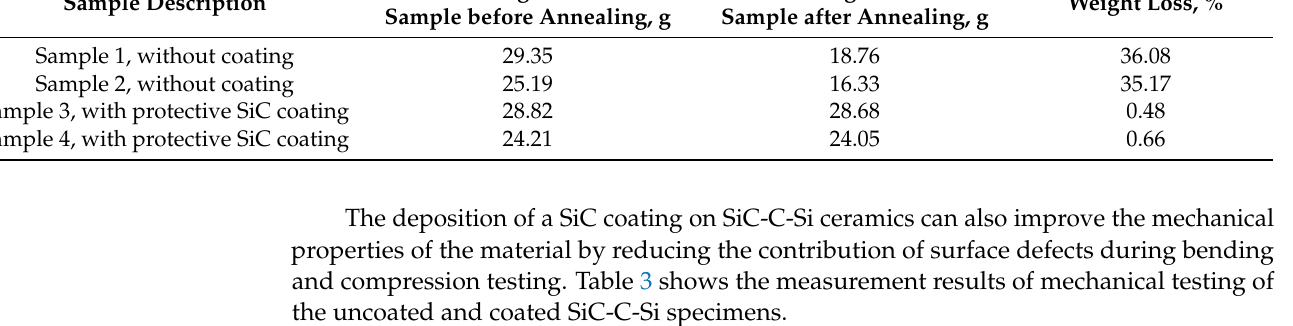
Table 3. Comparison of the strength characteristics of SiC ceramics with SiC-C-Si/50-40-10 composi- tion without coating and with a gas-tight SiC coating.